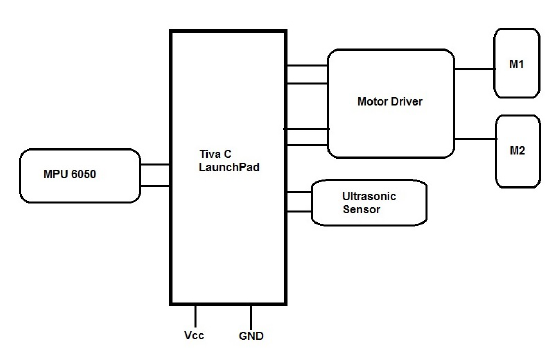
Figure 8. Block Diagram